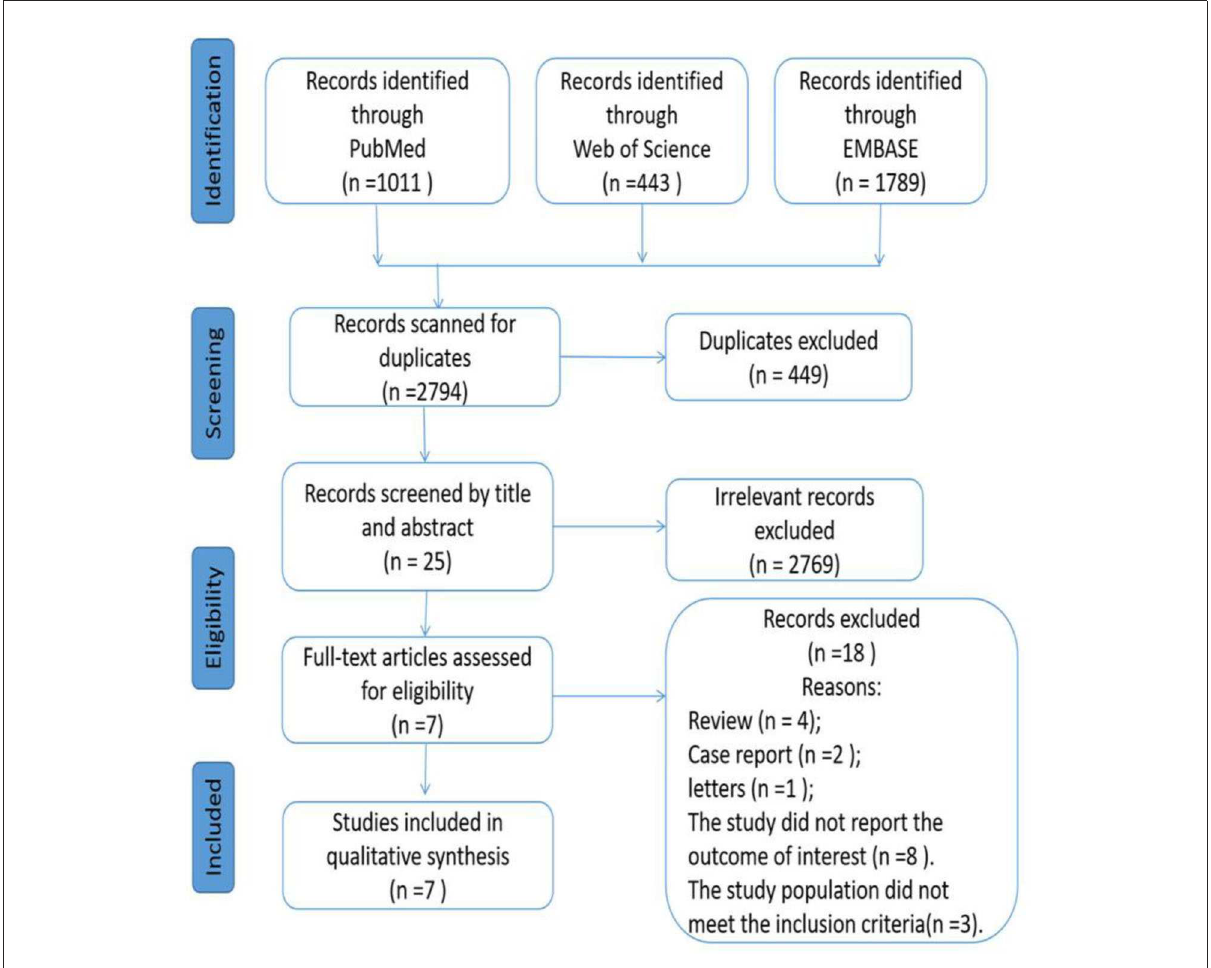
FIGURE1 PRISMA flowchart of study selection